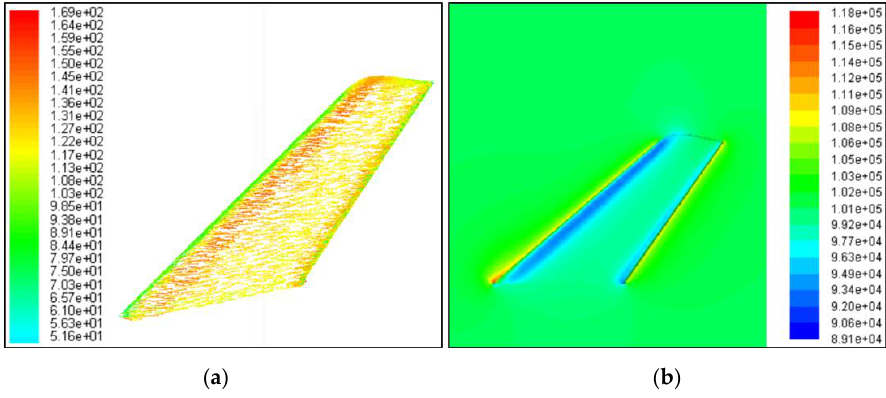
Figure 14. Flow field analysis: X t = 2.5 m; V ∞ = 125.8 m/s; ( a ) Vector display, velocity (m/s); ( b ) Section y = 0, static pressure (Pa).